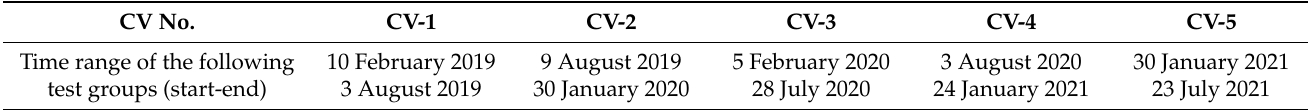
Table 3. Temporal summary of cross validation test